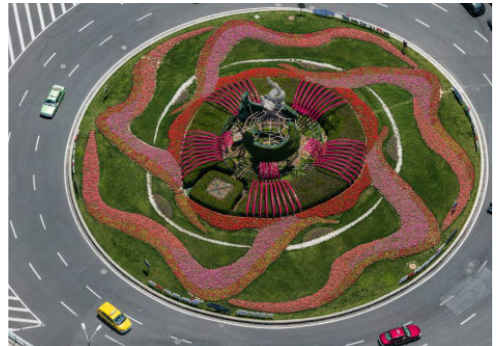
Figure 3. Image-2 Image to be registered